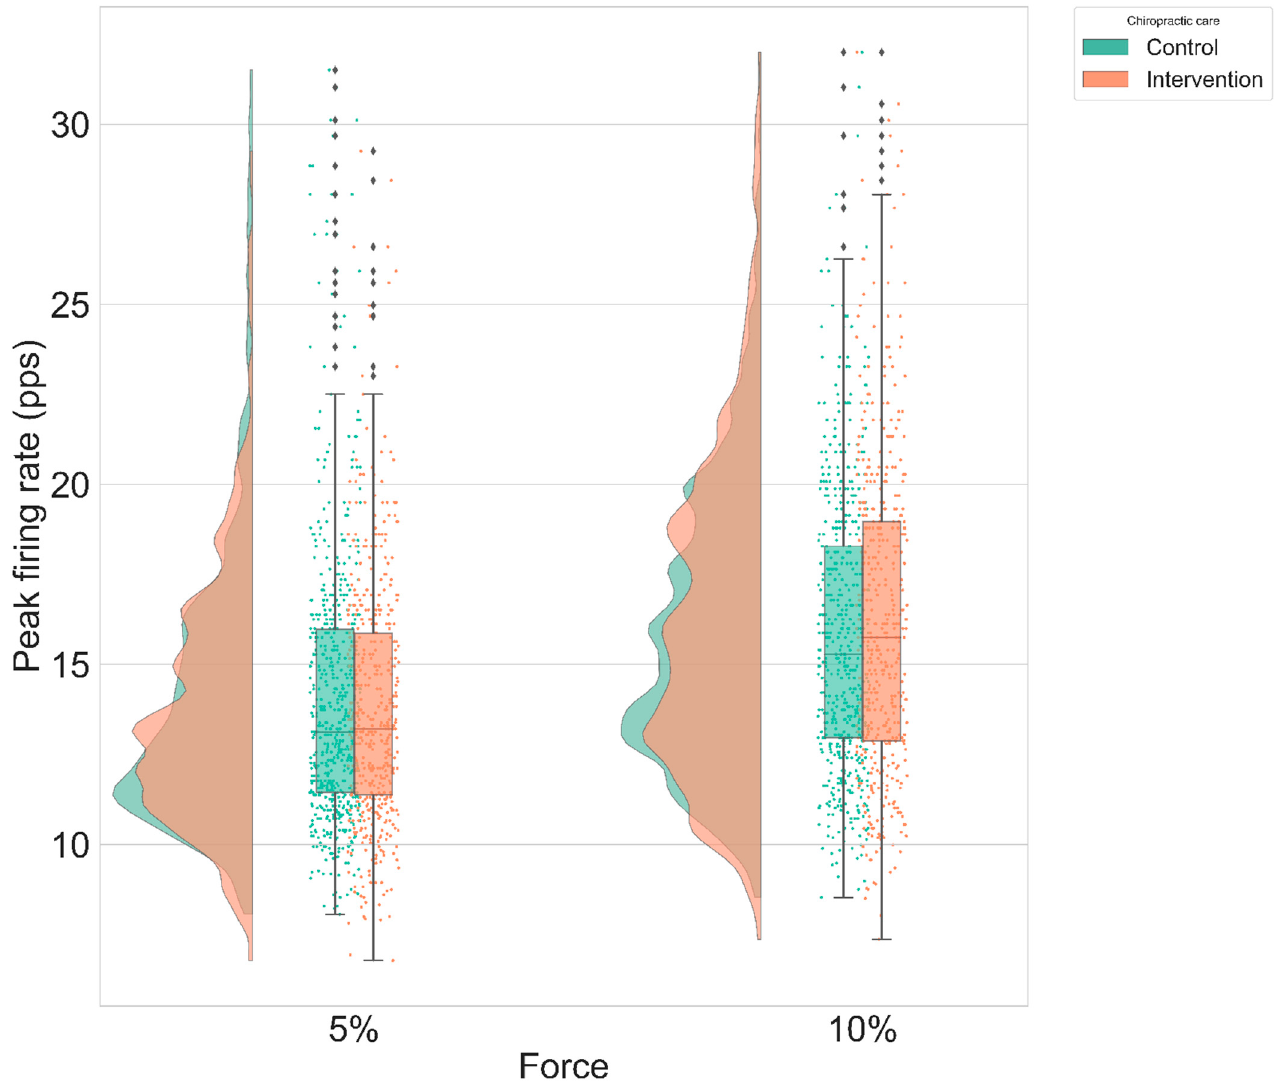
Figure 9. Group distribution plot of the PFR after intervention (control vs. spinal manipulation) for “ramp & maintain” condition adjusted to baseline.